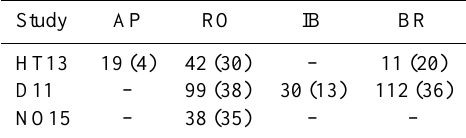
Table 3. Summary of accumulated volume ice-production estimates (km 3 ) from various studies (Haid and Timmermann (2013) – HT13; Drucker et al. (2011) – D11; Nihashi and Ohshima (2015) – NO15). Corresponding results of this study are given in parenthesis. MODIS estimates vary between studies due to different sample intervals of each comparison study we tried to match in the best possible